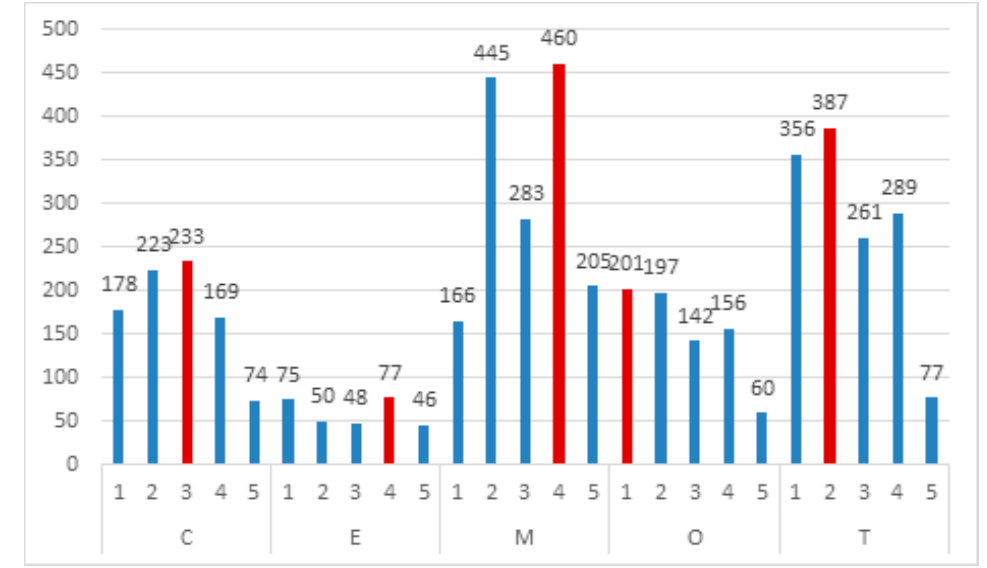
Figure 10. Visualization bar chart of vintage groups by highest energy use among the medians (kW/m 2 y) by vintage group in the amounts of energy usage by facility use in each group in Table 9. Table 9. Amounts of energy usage by facility use in each vintage